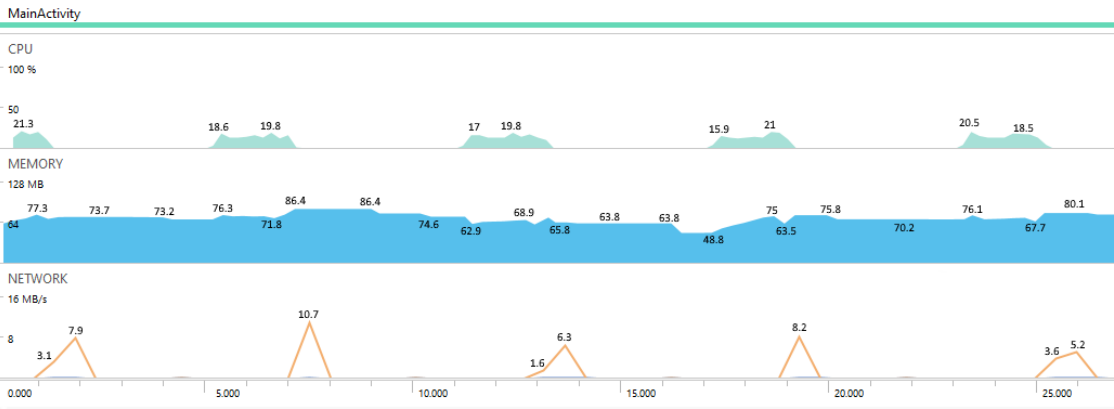
Figure 9. Multiple 2.5 MB file uploads.